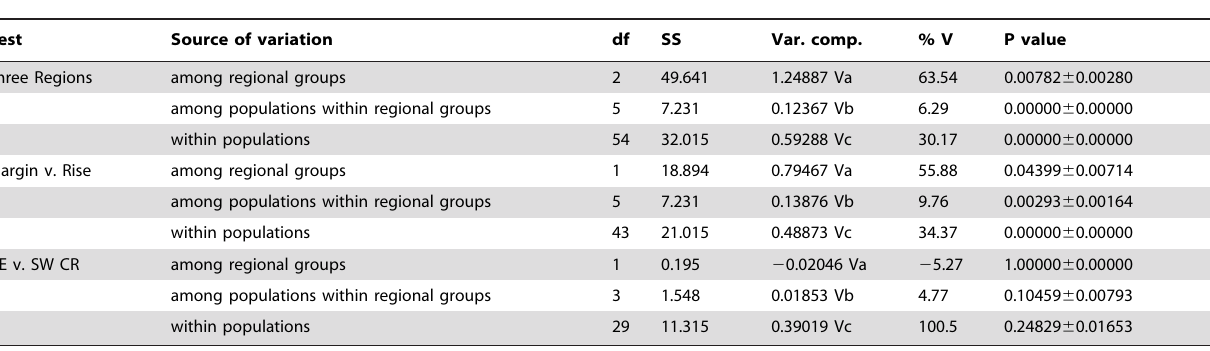
Table 8. 16S AMOVA results for Hyalinoecia longibranchiata